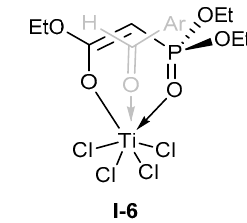
Figure 3. Titanium chelate-complex formation.